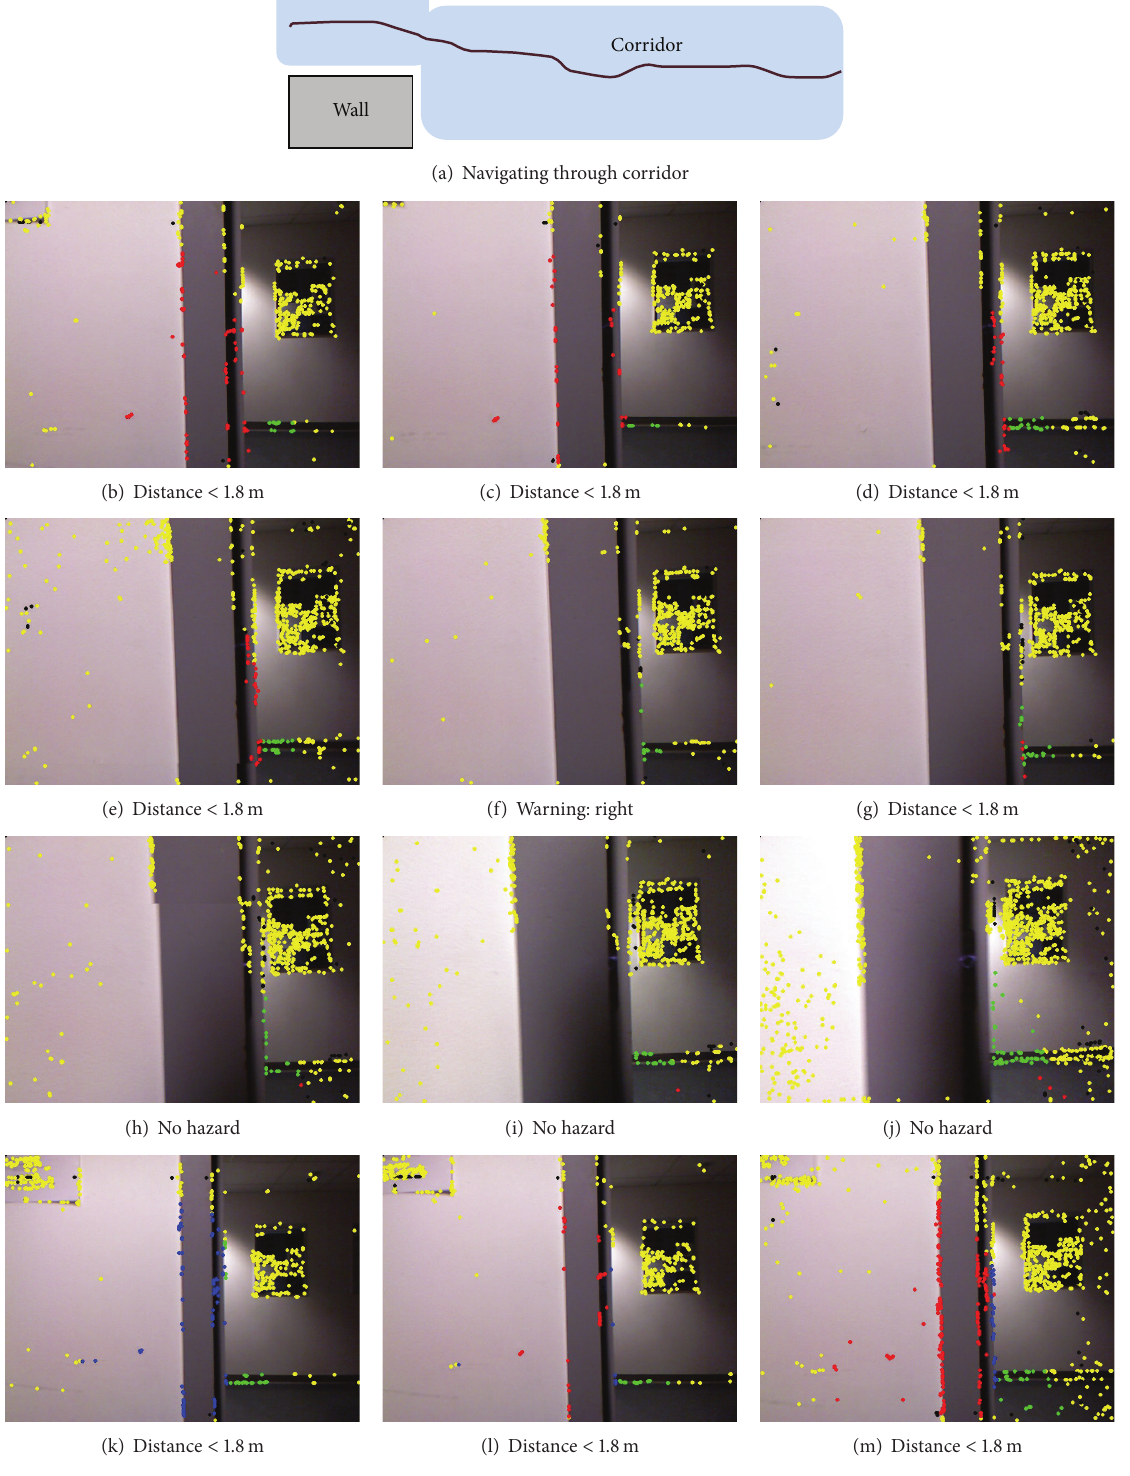
Figure 13: The navigation system’s visual output on an indoor video sequence of walking through a corridor coming in front of a wall. Here, (a) describes the navigational path by the subject (blind person). The system counts frames for consistent presence of hazard (b) till (e) and then generates voice signal “right” on frame (f). Similarly, the system starts counts on frame (g) but then no warning is generated because it loses red points in subsequent frames till frame